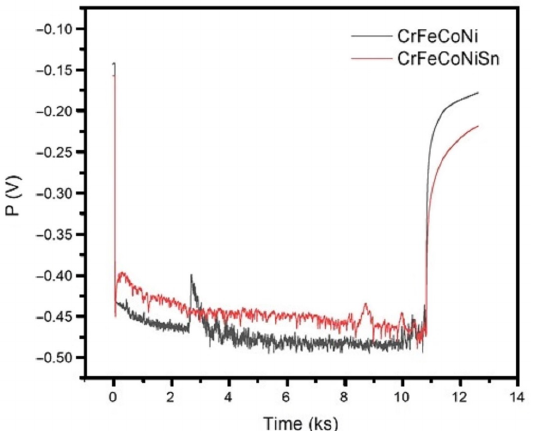
Figure 9. Sliding potential for CrFeCoNi and CrFeCoNiSn alloys tested in 0.6 M NaCl solution at ambient temperature.